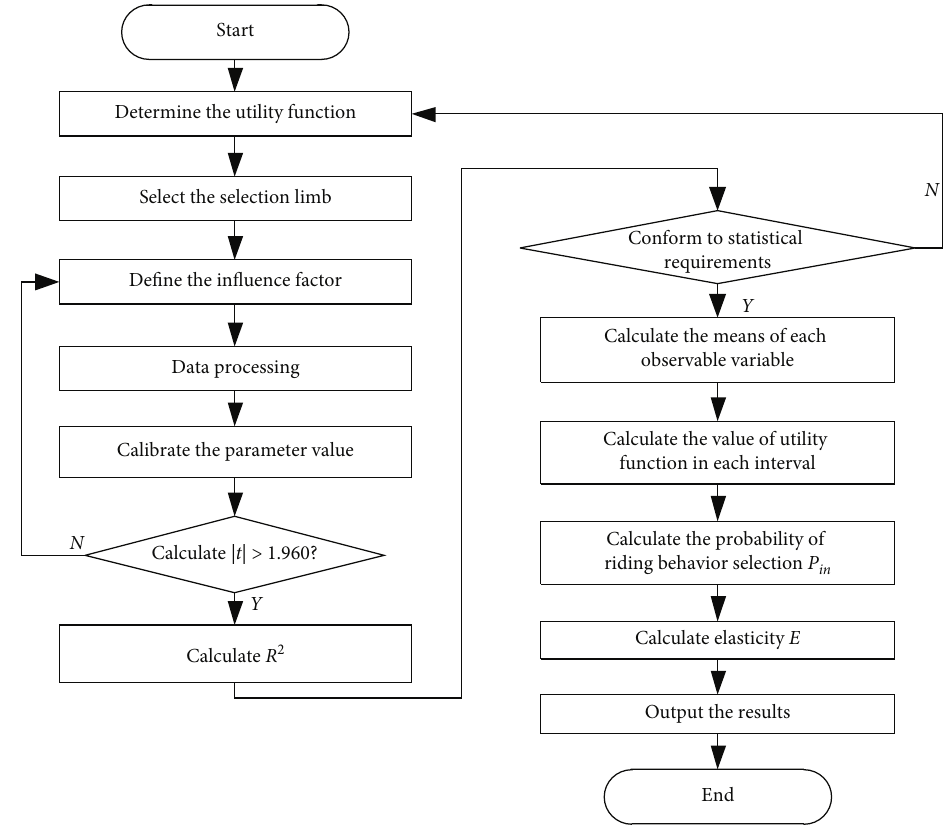
Figure 3: Model calculation workflow. Table 6: Calibration of influencing factors of the model.